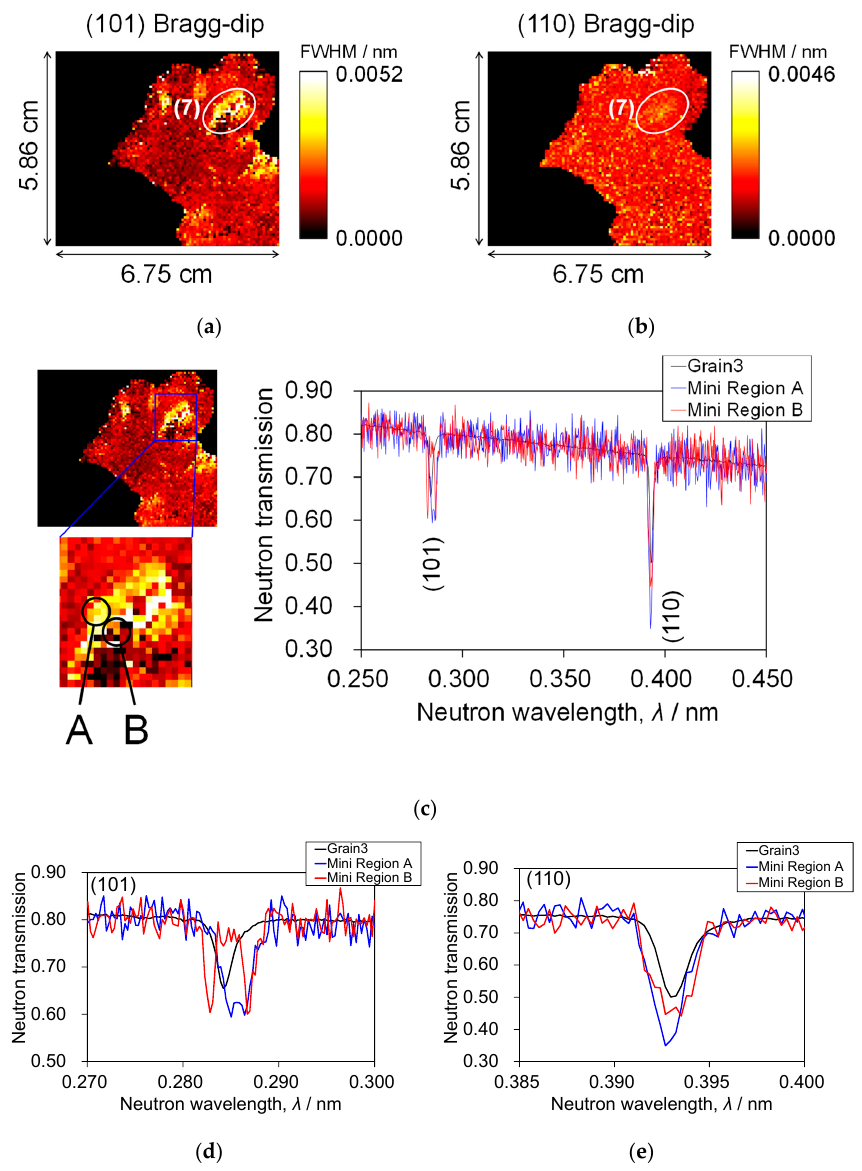
Figure 7. ( a ) Imaging of FWHM of (101) Bragg-dip in Grain 3. ( b ) Imaging of FWHM of (110) Bragg-dip in Grain 3. ( c ) Comparison of neutron transmission spectra at Mini Regions A, B and entire Grain 3. ( d ) Comparison of (101) Bragg-dip profiles at Mini Regions A, B and entire Grain 3. ( e ) Comparison of (110) Bragg-dip profiles at Mini Regions A, B and entire Grain 3.